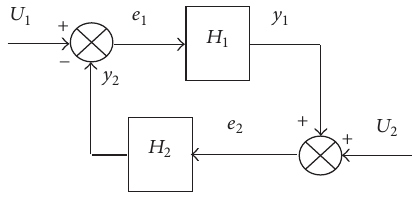
Figure 3: General closed-loop system.